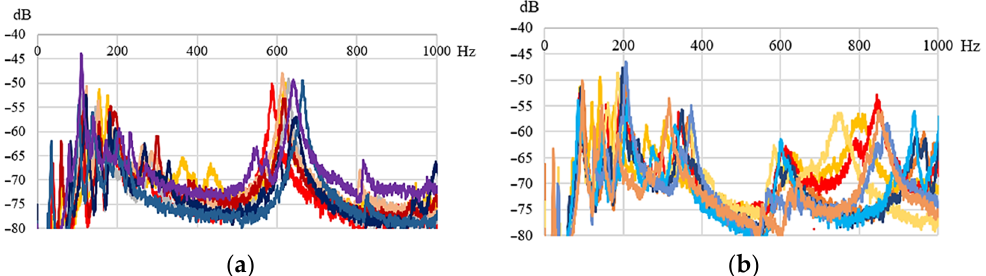
Figure 7. Spectral density diagrams for specimens: ( a ) without artificial defects in the connection between composite layers and ( b ) with defects in the timber ‐ to ‐ concrete connection.